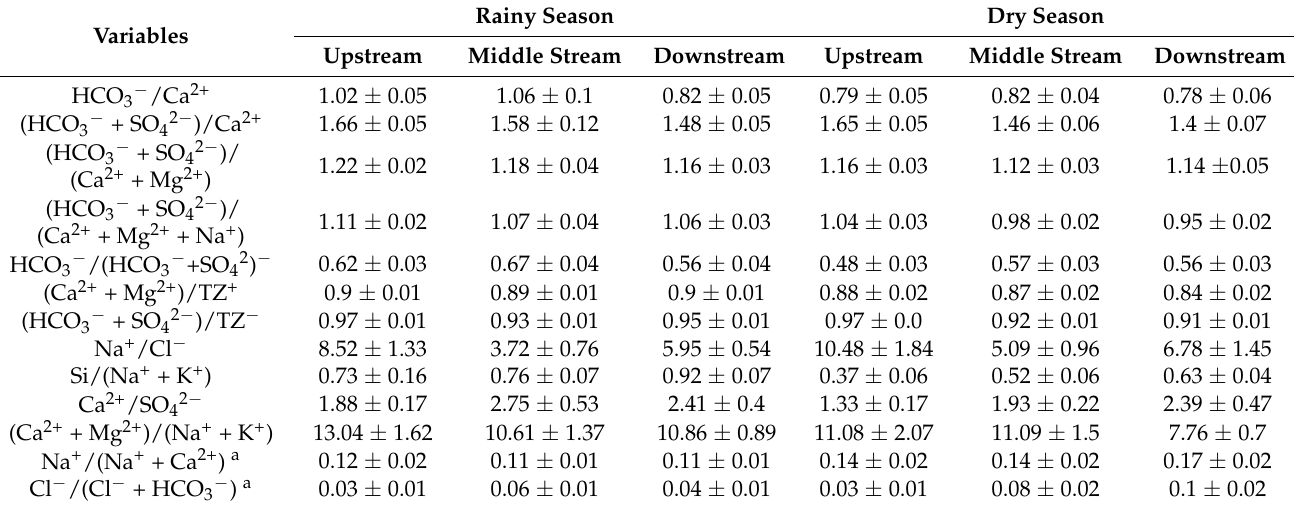
Table 3. Ionic ratio (Mean ± Se) of the surface water during the rainy season and dry season in the different reaches of the LR (meq/L). Rainy Season Dry Season Variables Upstream Middle Stream Downstream